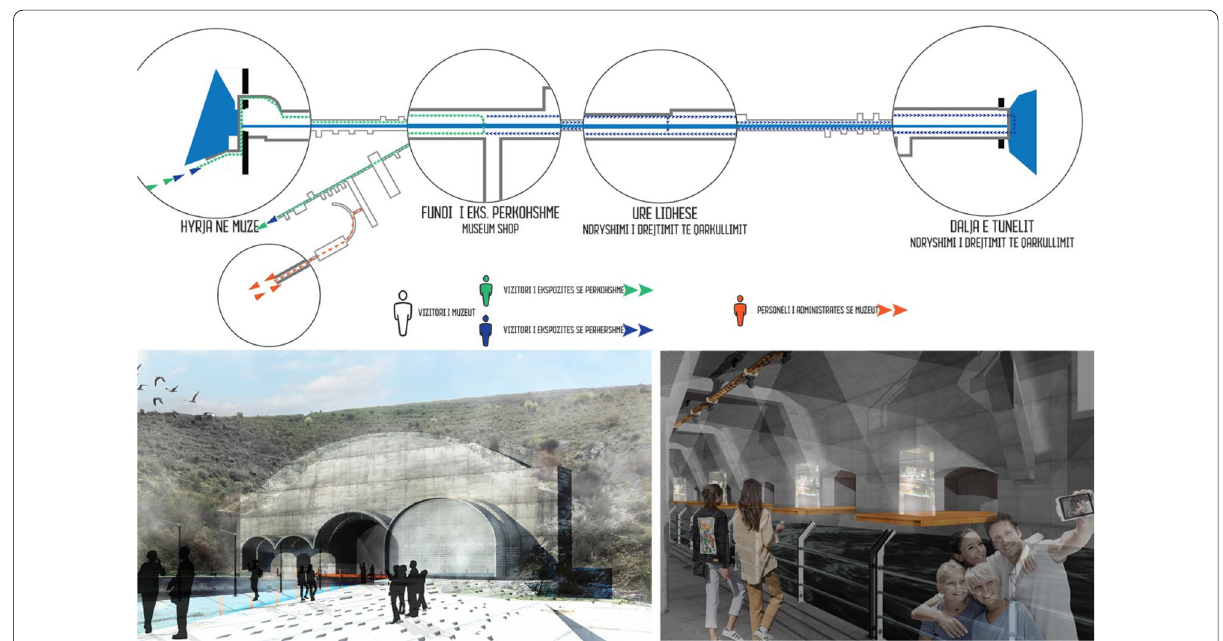
Fig. 17 The interior project of the museum “ Porto Palermo’s military base ”, diploma thesis of Debora